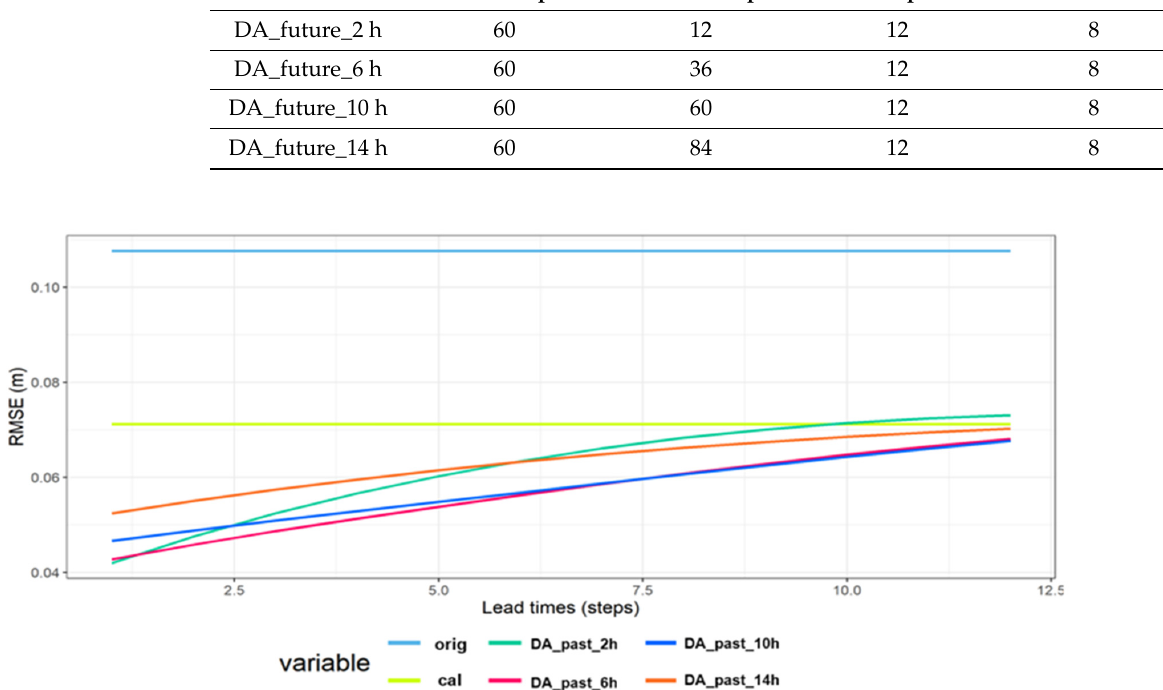
Table 4. The conditions for DA experiment 2-1: varying the future DA window.